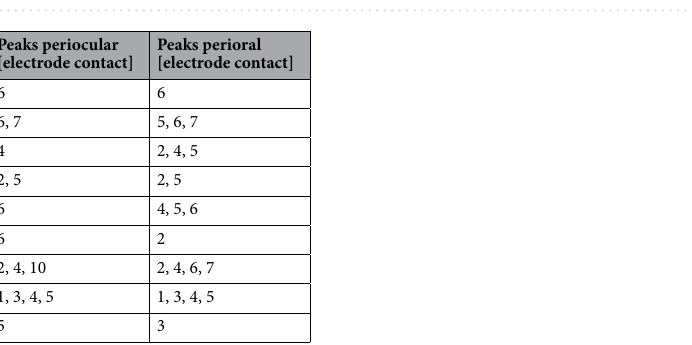
Figure 8. Normalized EMG responses of the M. orbicularis oris as function of the contacts on the fully inserted electrode array. The color gradient depicts the radiologically determined electrode facial nerve distance (red: shortest distance; black: longest distance) for each subject. The horizontal dashed line indicates the arbitrarily chosen EMG threshold at 75% normalized EMG response.